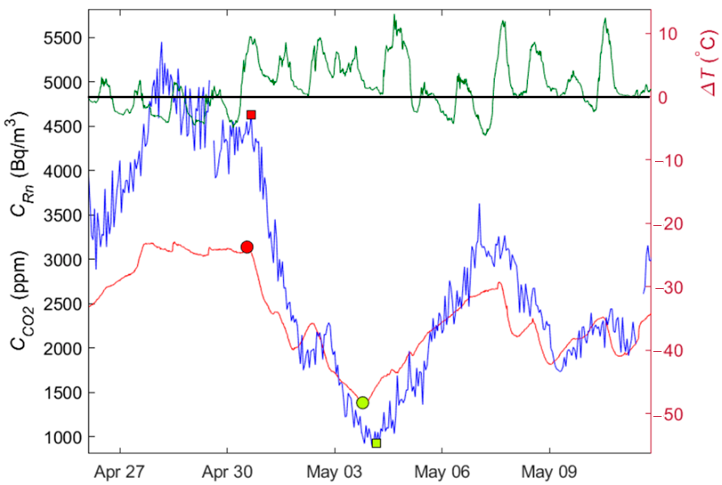
Figure 7. Radon concentration variation (blue) and CO 2 (red) for event number 3 in May 2015. The temperature gradient is shown (green) and the 0 ˚ C is marked with a black line. Red markers show the start of the degassing, and the green ones show the end; a square is used for Rn and a circle for CO 2 .